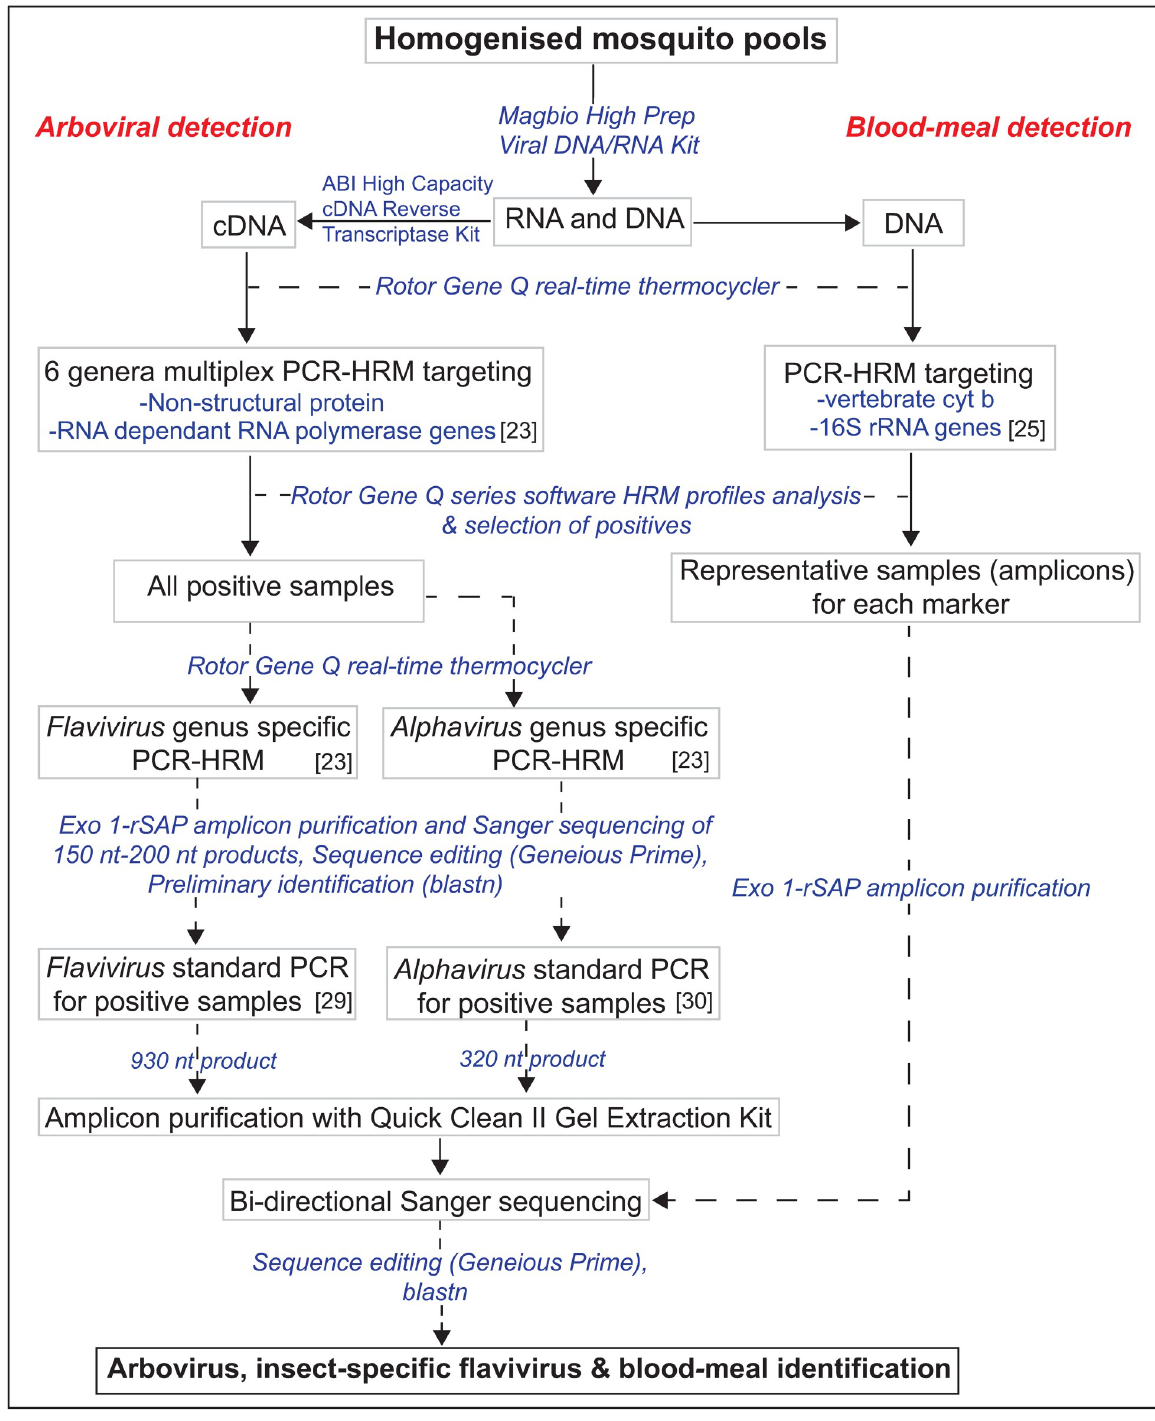
Fig 2. Flowchart showing the molecular detection of arboviruses, insect-specific flaviviruses and determination of blood-meal sources of blood-fed mosquitoes.